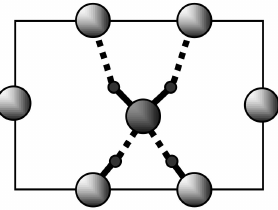
Figure 10. The system of hydrogen bonds of the H 2 O molecule (in the center) and the OH groups in the cavity of the hemimorphite mineral.